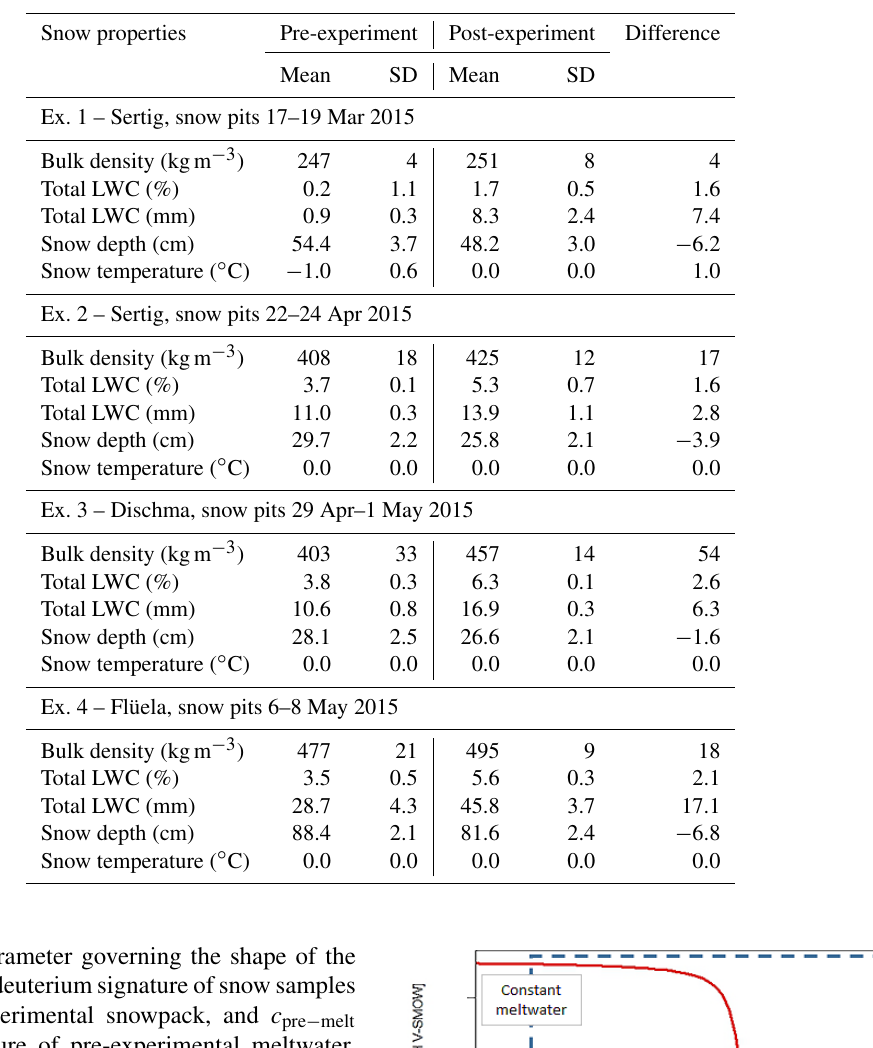
Table 2. Experimental snow block conditions before and after each experiment. Bulk density values were derived from the entire snow profile sample.